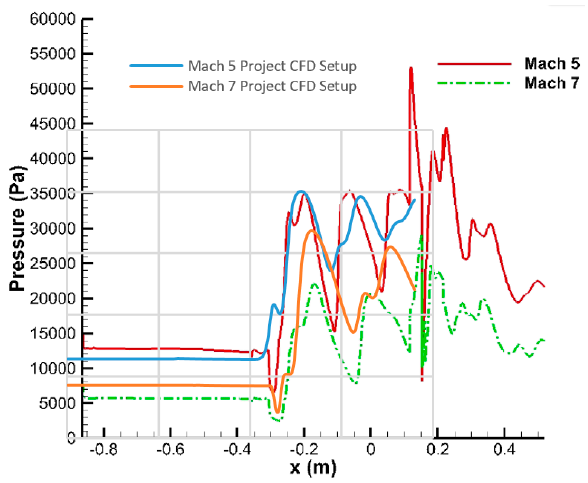
Figure 13. Pressure plot along the centre line of the inlet and isolator.